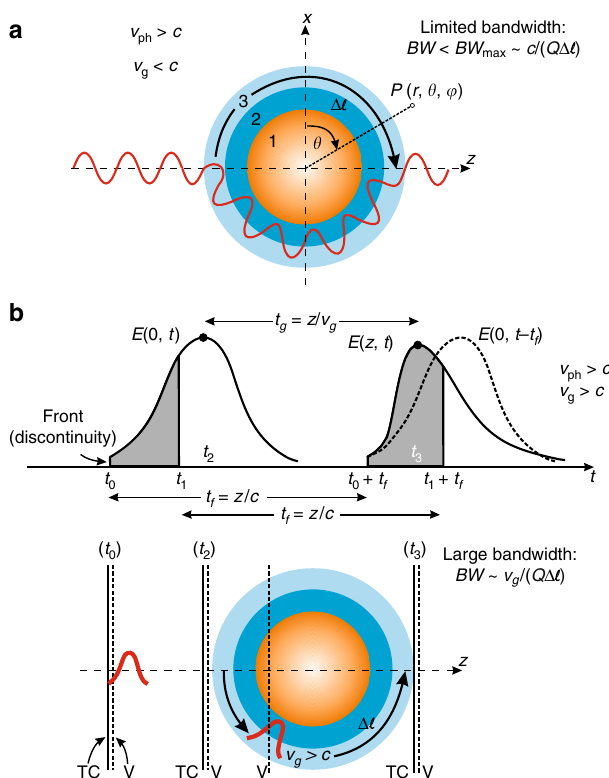
quasi-conformal transformation-optics cloaks, Fig. 1 Bandwidth characteristics of conventional and tachyonic invisibility cloaks. a In conventional cloaks, be them Euclidean, plasmonic or mantle cloaks, a wavelet propagates with a superluminal phase velocity, v ph , but subluminal group velocity, v g , smoothly around a three-dimensional (here, spherical) object, preserving the phase at the exit/right-hand side of the cloak compared with a wavelet propagating in vacuum. This renders the object invisible to the incident radiation but, because v g < c , over only a limited bandwidth, BW < BW max , with BW max being proportional to the vacuum light speed, c , and inversely proportional to the extra path, Δ ℓ , taken by the wavelet around the object 22 . At visible frequencies, BW max can be extremely narrow, of the order of ~0.00005% of the visible spectrum 22 – 24 — i.e., the object becomes invisible at, approximately, a single wavelength only. b In a tachyonic cloak (TC), both, the phase and the group velocities are superluminal over broad spectral ranges. Here, the peak of (the envelope of) an ultrashort pulse travels faster than the speed of light in vacuum, c , in a such a way that a wavefront of the pulse (shown with solid or dashed vertical lines in the lower part) is, at all times, at the same position as the wavefront of a pulse traveling in vacuum (V), despite the fact that the pulse traversing the cloaked object takes a longer route (around the object) Δ ℓ compared with a pulse traveling straightly in vacuum. This extra pathlength is, here, balanced out by the correspondingly larger group velocity of the pulse in the cloak ( v g > c ), so that the ratio v g / Δ ℓ is maintained large — and, in principle, with no upper bound. The attained bandwidths can, thus, now be extremely broadband, even for phase-preserving cloaking of highly scattering objects in air. There is no violation of relativistic causality with such a scheme because, as explained in the main text and the Supplementary Note 2, only the shaded parts of the input and output pulses, shown in the upper part, are causally